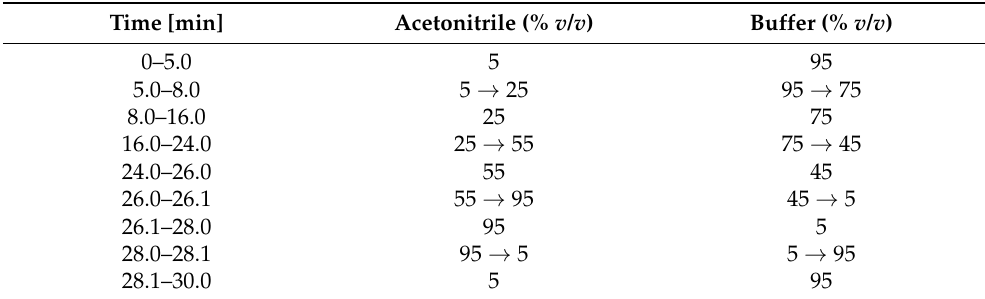
Table 4. Gradient conditions for the separation of enalapril and its related substances.